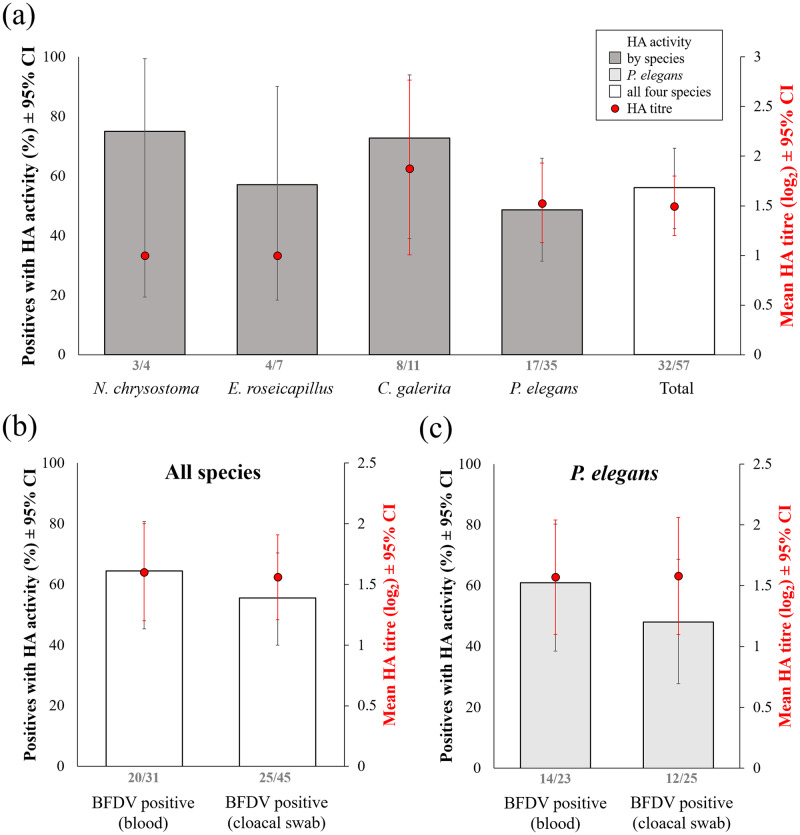
BFDV antigen excretion into feathers (positive HA result), in birds which were BFDV positive as detected by qPCR, in at least one sample type (either blood or cloacal swabs, or both).Bars show percentage of birds with antigen excretion out of all birds tested ± 95% confidence intervals, with number of birds with detectable antigen excretion out of total number of birds tested at the base of bars. Dots show average HA titre (relative amount of antigen (log2)) in BFDV positive birds with HA activity ± 95% confidence intervals. Percentage of birds with antigen excretion, and mean antigen titres, are shown per species (panel a), and per sample type that was BFDV positive when tested with qPCR, for all four species combined (panel b) and for Crimson Rosellas only (panel c).